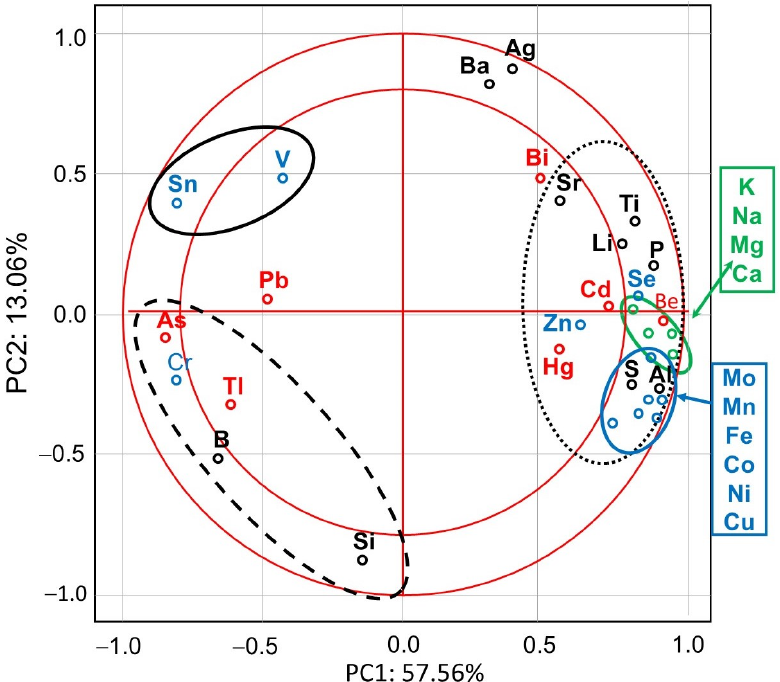
Figure 2. Principal component analysis (PCA) in honey bees exposed and unexposed to imidacloprid: two-dimensional projection of the variables (biominerals) in the principal components PC1 and PC2. Explanations: doted-line ellipse = bees were fed a diet without imidacloprid-control group; solid-line ellipse = bees were fed a diet containing a 5 ppb addition of imidacloprid; dashed-line ellipse = bees were fed a diet with a 200 ppb addition of imidacloprid. The levels of all the electrolytic bioelements in the worker bee bodies decreased due to IMD exposition proportionally to IMD dose, but the 5 ppb dose of IMD had a strong impact. (Figure 3). This corresponds with the PCA results (Figure 2) as all of the bioelements very highly influenced PC1 (their values were above + 0.8) and were also highly positively correlated with one another. IMD decreased the levels of 8 out of the 11 enzymatic bioelements (Figure 4) but increased those of only 3 bioelements (SN, V, Cr). The impact of the feeding with addition of both 5 ppb and 200 ppb of IMD was similarly strong in about 50% of the bioelements, i.e., 5 ppb of IMD influenced the biomineral content in a really marked way. PCA showed (Figure 2) that all of these eight bioelements had high positive values of PC1 and were very highly positively correlated with one another. On the other hand, Sn, V, and Cr had negative PC1 values while being at the same time positively, but not closely, correlated